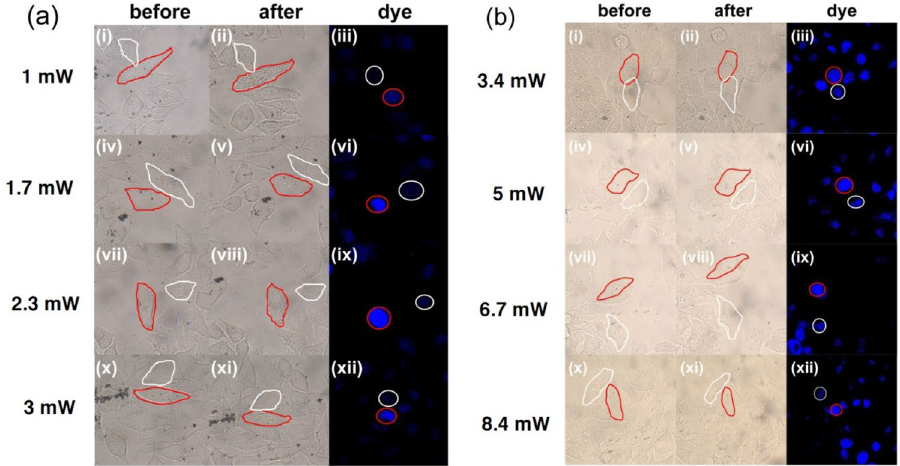
Figure 6. ( a ) shows GNBs with an AR of 2.92 induce cell apoptosis under 760 nm fs pulsed laser irradiation. ( b ) GNBs with an AR of 2.92 induce cell apoptosis under 760 nm continuous laser irradiation. The white circles represent control cells and the red circles represent experimental cells.